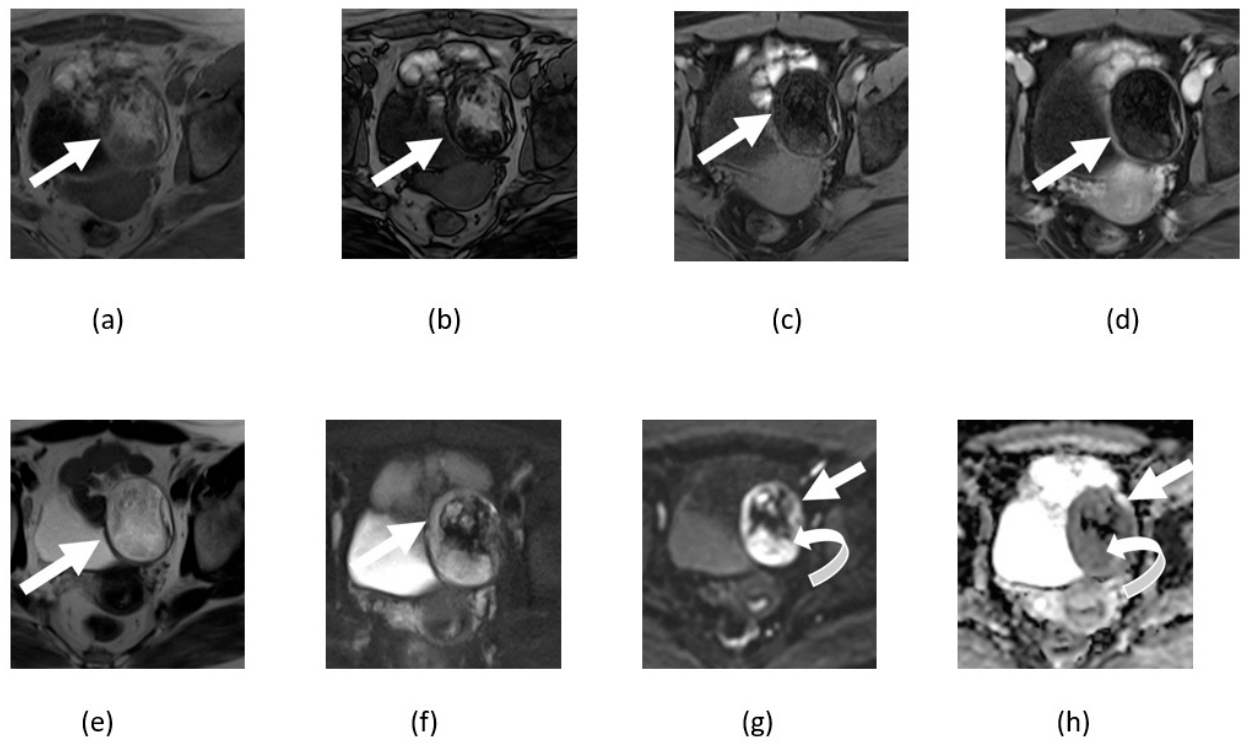
Figure 11. Axial T1-weighted in ( a ) and out ( b ) phase, T1-weighted pre- ( c ) and post-contrast ( d ), and T2-weighted non fat suppressed ( e ) and T2 weighted fat suppressed ( f ) images shows fat containing left adnexal lesion compatible with a mature cystic teratoma (straight arrow). Corresponding DWI ( g ) and ADP maps ( h ) show peripheral component with restricted diffusion (curved arrow).